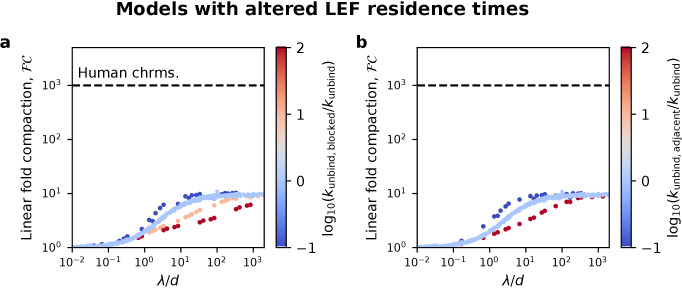
Fold linear compaction in pure one-sided extrusion models in which LEF residence times are altered by contact with other LEFs.(a) Fold linear compaction in a model in which blocked one-sided LEFs have a different unbinding rate, kunbind,blocked. A LEF is blocked if it cannot extrude because it has encountered another LEF. Red and pink denote LEFs that unbind more rapidly when blocked; dark blue denotes LEFs that unbind more slowly when blocked. (b) Fold linear compaction in a model in which each (one-sided) LEF has a different unbinding rate, kunbind,adjacent, if it is directly adjacent to another LEF. Dark blue denotes LEFs that unbind more slowly when adjacent to each other. For both panels, light blue is data for pure one-sided extrusion, with kunbind,blocked=kunbind and kunbind,adjacent=kunbind, respectively.